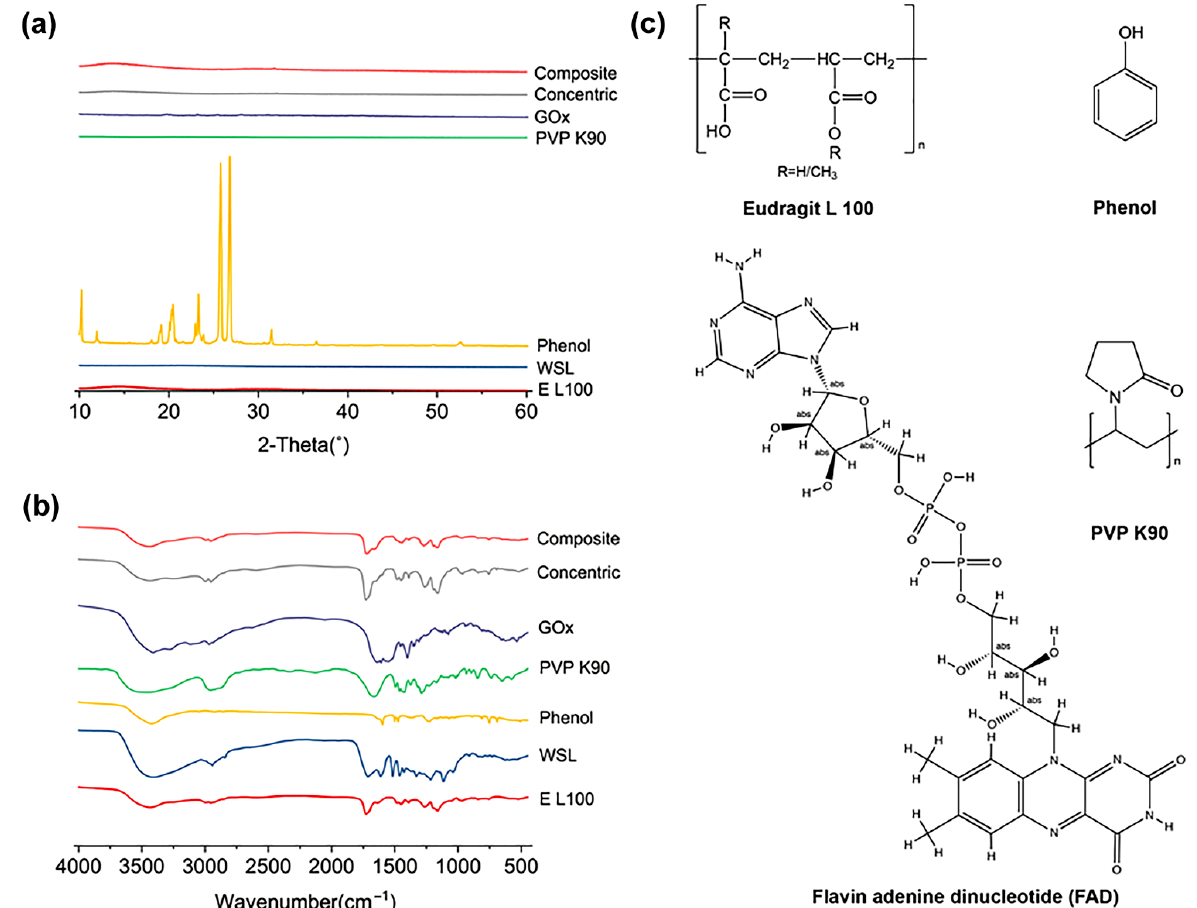
Figure 7. Physical state and compatibility characterization: ( a ) XRD pattern; ( b ) FTIR spectra; and ( c ) chemical structure formula of the raw materials.